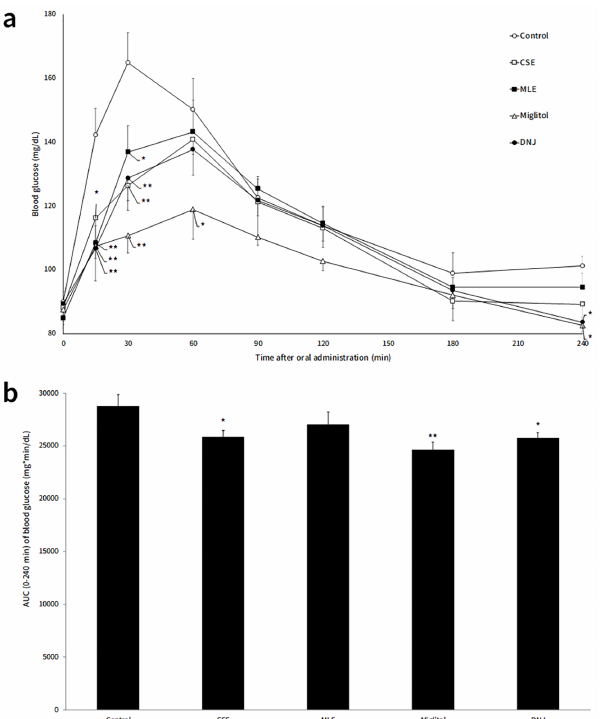
Fig 2. The effects in suppressing the blood glucose in rats. The rats received orally administered sucrose (2 g/kg B.W.) 15 minutes after each samples administration (equivalent to 5 mg DNJ or miglitol/kg B.W.). Blood glucose levels were determined from tail blood sample. (a) is the transition of blood glucose concentration and (b) is area of under curve of blood glucose concentration. Results are given as means ± SE. (cid:3) p < 0.05 versus control; (cid:3)(cid:3) p < 0.01 versus control.